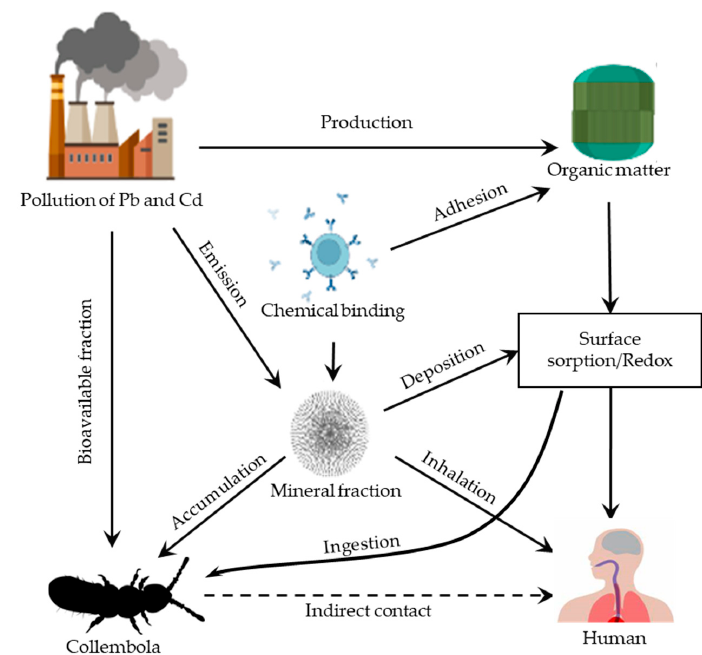
Figure 3. The process involved in the interactions between the Pb- and Cd-contaminated urban soil and collembolan and collembolan species.